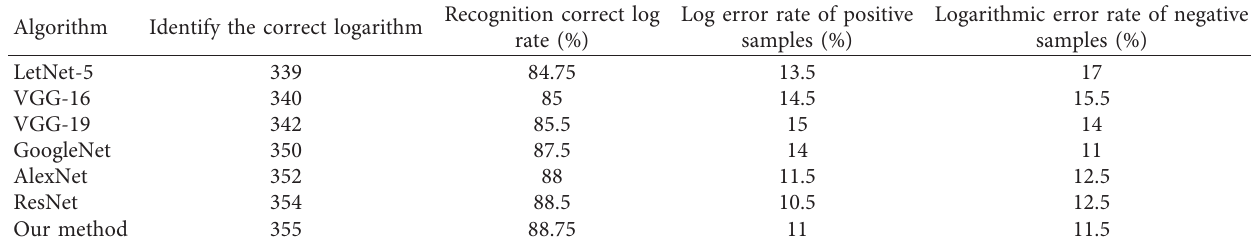
Table 8: Comparison of total recognition rates of facial features of different models.